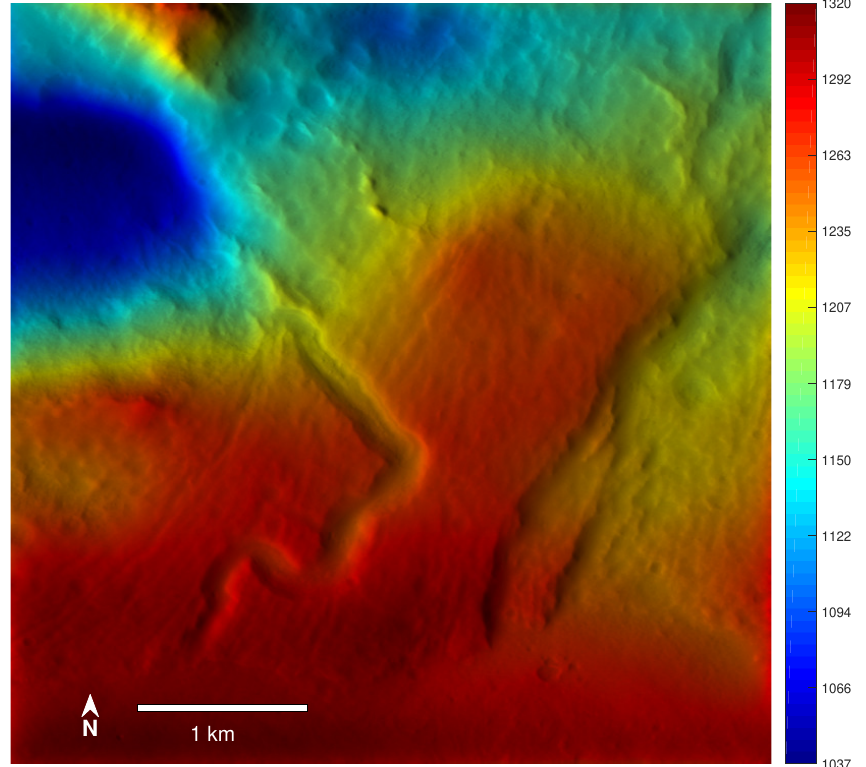
Figure 4. Color-coded DTM produced with the new method including atmospheric